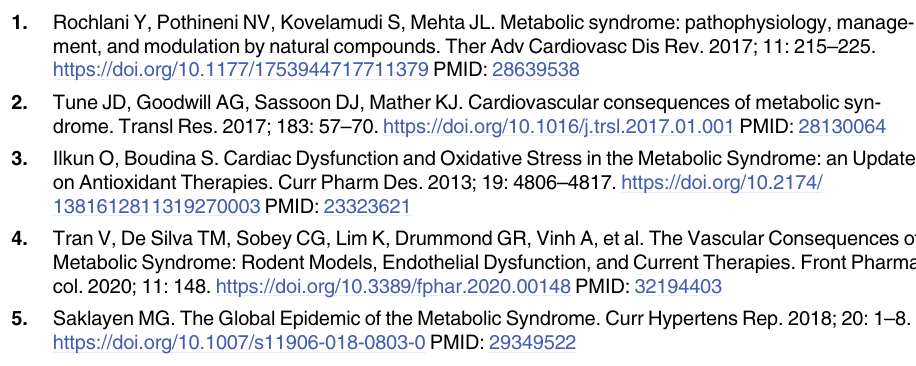
S1 Table. A & B. Firmicutes to Bacteroidetes ( Firmicutes / Bacteroidetes) ratio in control and HFFD groups, respectively. S2 Table. Composition of the standard chow and the high-fructose high-fat diets.